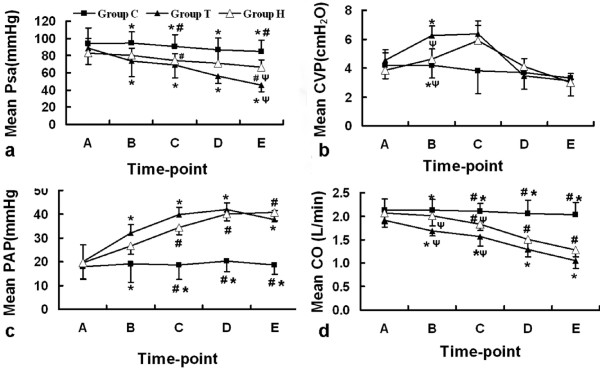
The change trend of MPsa, MCVP, MPAP and MCO. a, the change of mean Psa; b, the change of mean CVP; c, the change of mean PAP; d, the change of mean CO. * p < 0.05, group C comparing with group T; # p < 0.05, group C comparing with group H; Ψp < 0.05, group H comparing with group T.